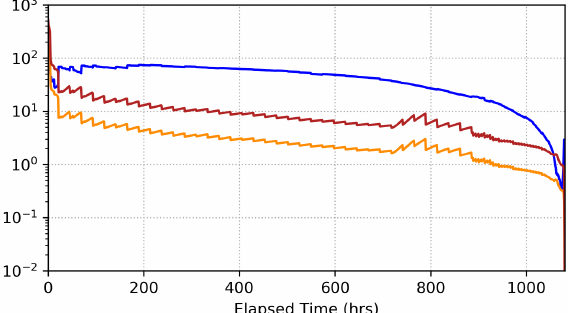
Figure 9. Position error (blue) and RTPC uncertainty (1- σ (orange) and 3- σ (red)) for fused filter in Small Optical Bias setup.